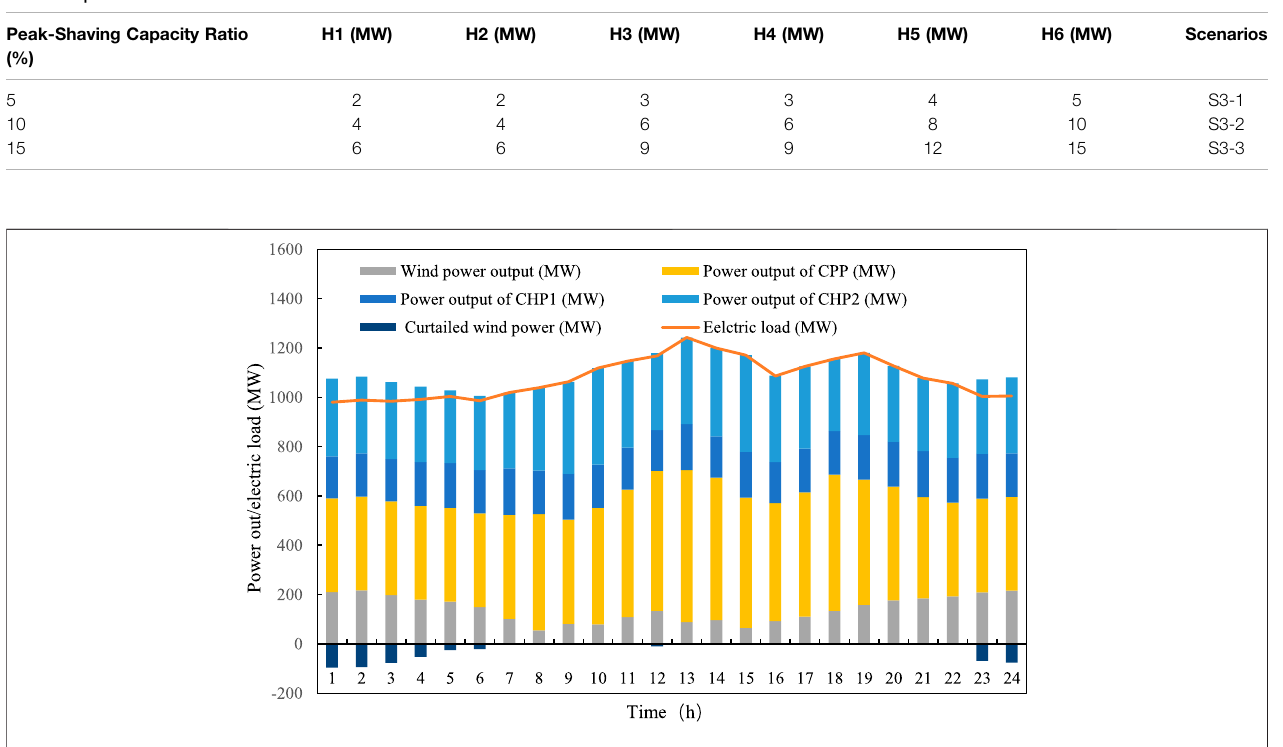
FIGURE 8 | Optimal original electricity dispatch results with curtailed wind power in